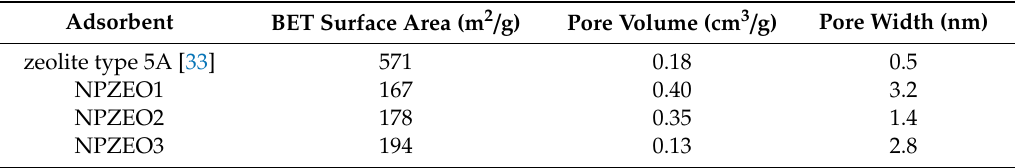
Figure 4. N 2 adsorption–desorption isotherms ( a ) and pore size distribution (PSD) ( b ) for NPZEO1, NPZEO2, and NPZEO3 samples. Table 2. Textural parameters obtained for zeolite Type 5A, NPZEO1, NPZEO2, and NPZEO3 adsorbents. BET,